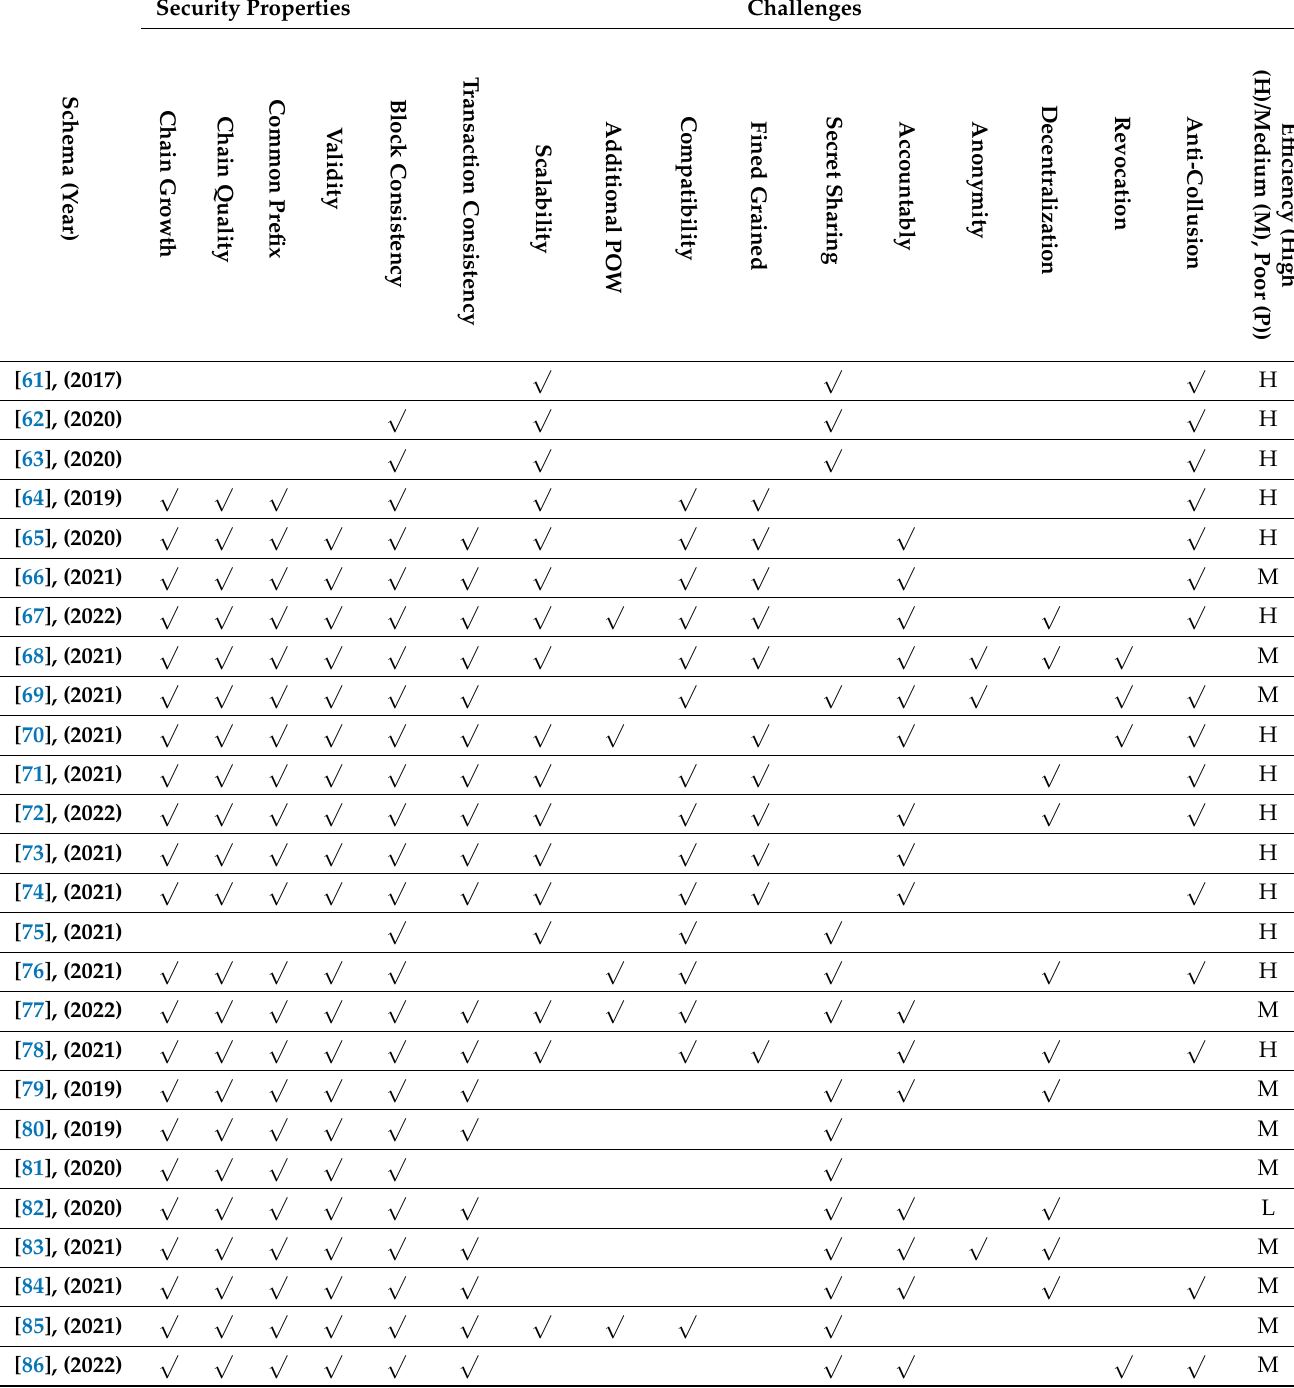
Table 4. Chameleon redaction mechanism challenge